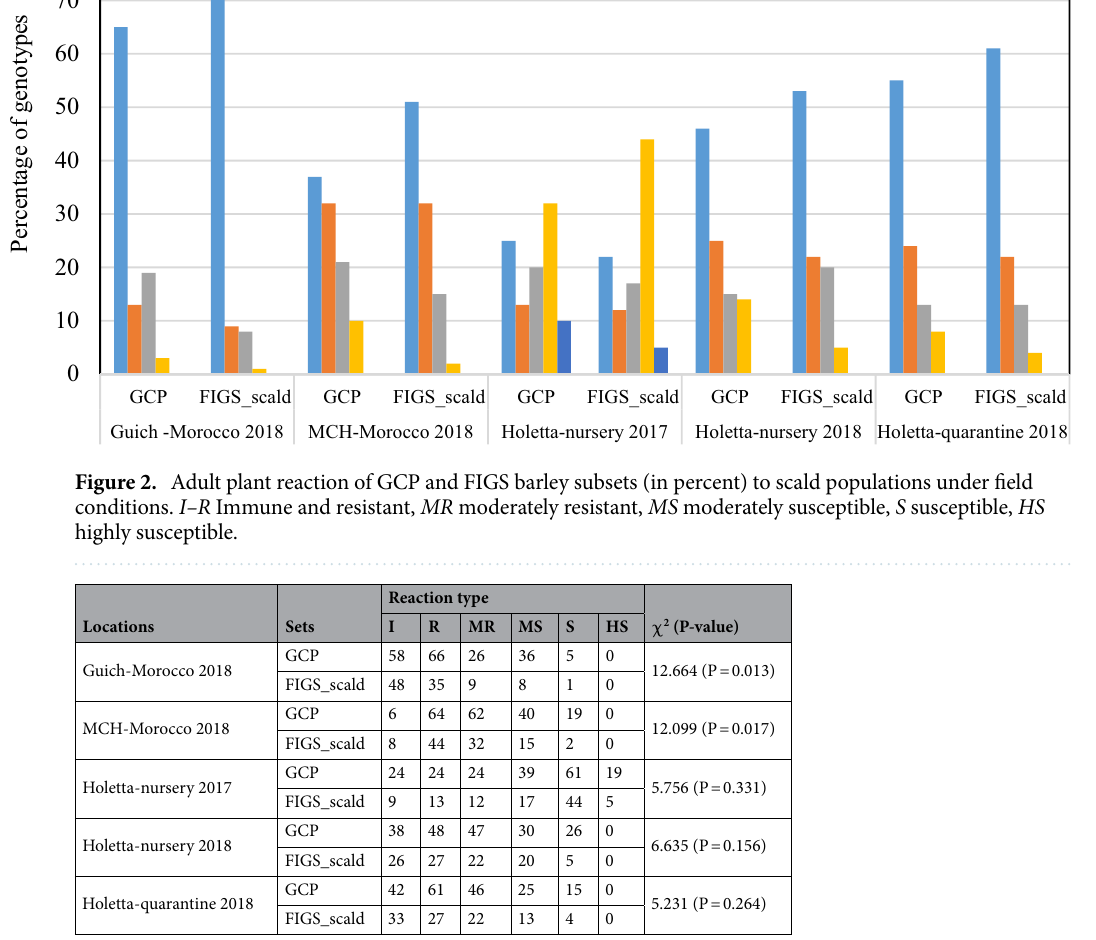
Table 1. Test of independence of adult plant reaction of FIGS and GCP barley subsets to scald evaluated under field conditions in Ethiopia (2017–2018), and in Morocco (2018) for each disease reaction class. I Immune, R resistant, MR moderately resistant, MS moderately susceptible, S susceptible, HS highly